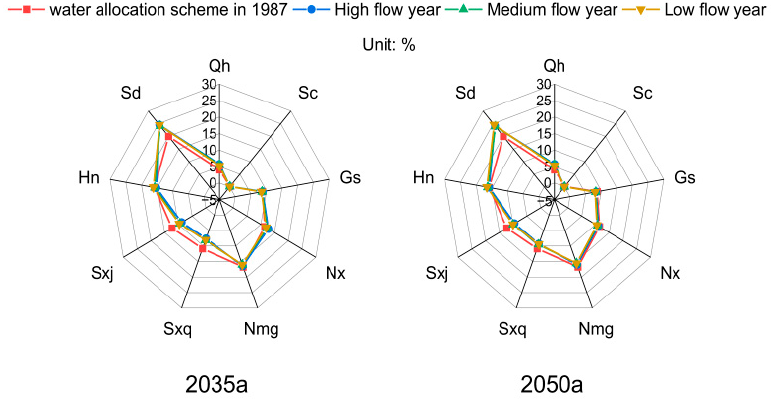
Figure 11. Consumption ratio of Yellow River surface water consumed under two water distribution schemes in 2035a and 2050a.